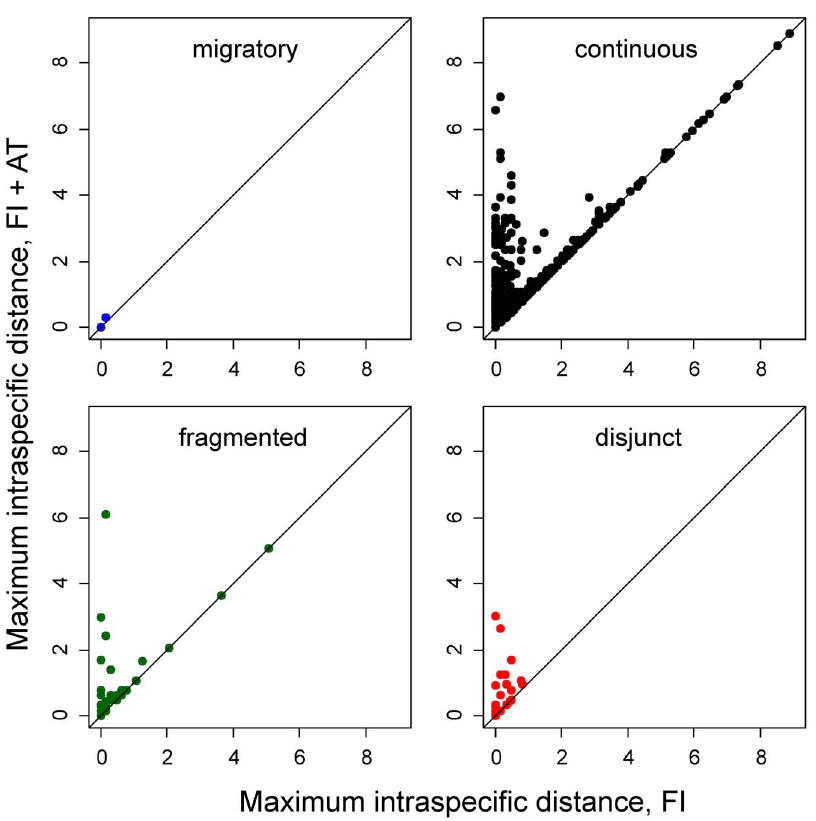
Fig. 5. Effect of increased geographic sampling on maximum intraspecific distance among species in the four distribution categories. Maximum intraspecific distance values for the Finnish samples (FI) are plotted against maximum intraspecific distance values after addition of the Austrian samples (FI +